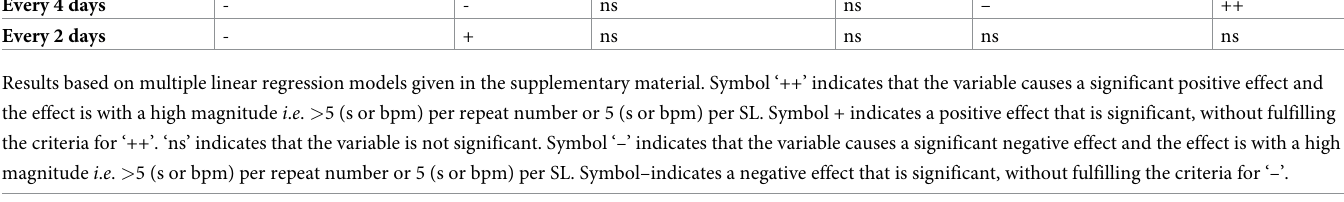
Table 7. Comparison of the significance of repeat number and standard length on the time taken to induce and lose touch responsivity, breathing rate and time taken to regain movement and recover for protocol 4 when used every 2 days vs every 4 days. Time taken to induce and lose touch Breaths per minute Time taken to regain movement and responsivity recover Protocol 4 Repeat number SL Repeat Number SL Repeat number SL - ns ns – ++ + ns ns ns ns Results based on multiple linear regression models given in the supplementary material. Symbol ‘++’ indicates that the variable causes a significant positive effect and the effect is with a high magnitude i . e . > 5 (s or bpm) per repeat number or 5 (s or bpm) per SL. Symbol + indicates a positive effect that is significant, without fulfilling the criteria for ‘++’. ‘ns’ indicates that the variable is not significant. Symbol ‘–’ indicates that the variable causes a significant negative effect and the effect is with a